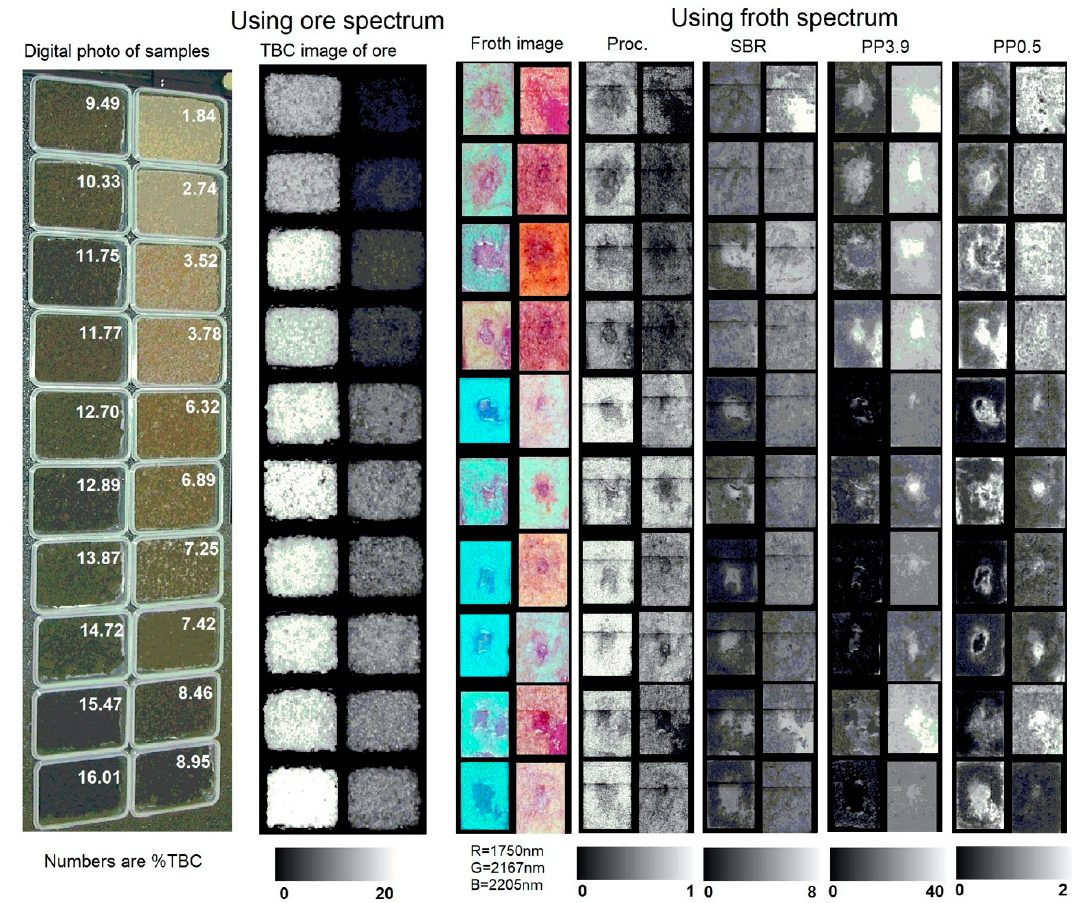
Figure 15. Froth imagery of sample suite #2 (20 samples) converted to predicted values using the models described in Section 4.2: processability (Proc.), solids / bitumen (SBR), %pp3.9, and %pp0.5. These are displayed as a grey tone scale, with the brightest values corresponding to the highest predicted values. The reader should discard the near circular central region of each image, where the removal of the impeller has disturbed and sometimes largely removed the froth. Additionally included for reference are the sample # and the previously presented color composite of froth imagery in the continuum removed reflectance (red = 1750 nm, green = 2167 nm, blue = 2205 nm). 5. Discussion